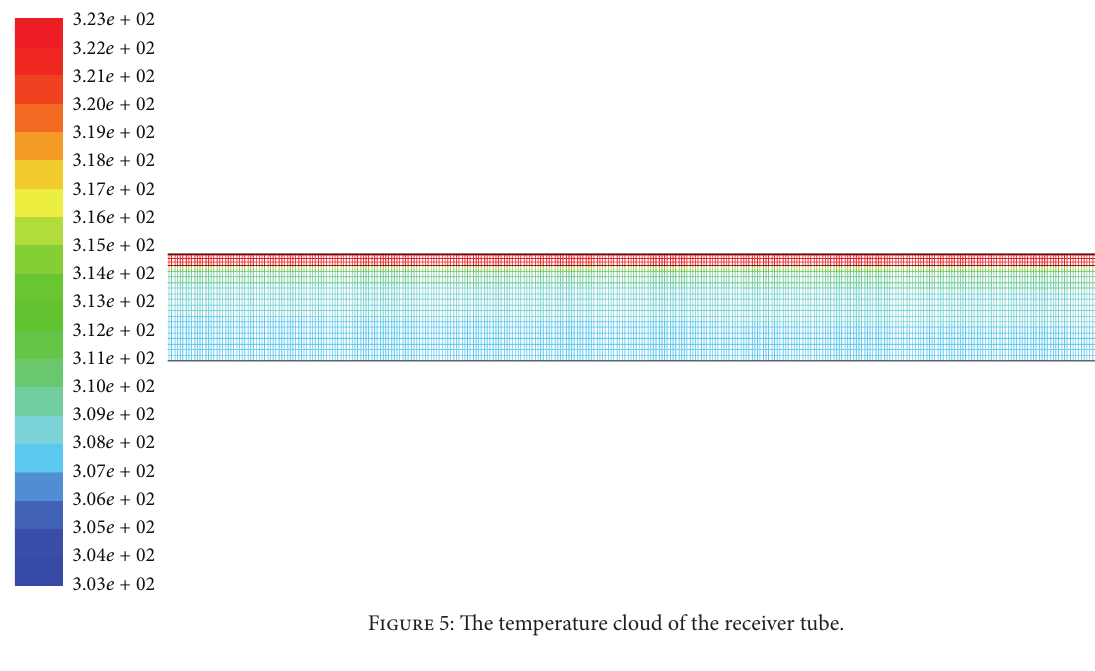
Figure 5: The temperature cloud of the receiver tube.